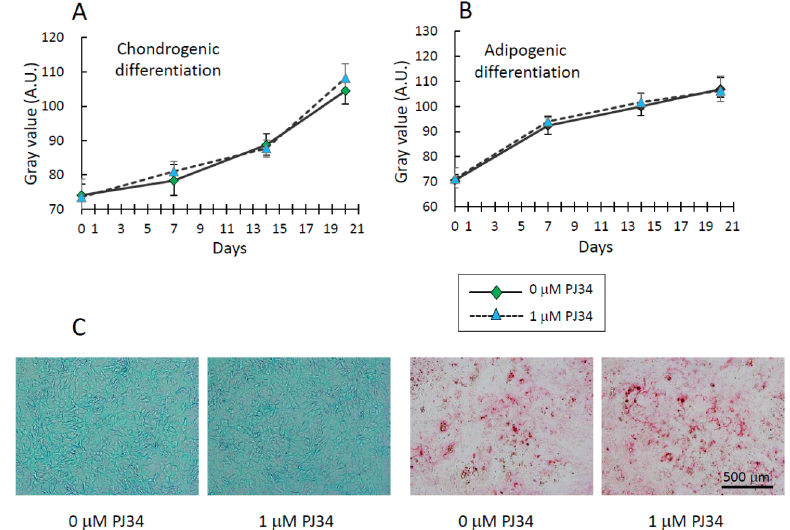
Figure 6. ( A ) Effects of PJ34 on chondrogenic differentiation of BMMSCs were analyzed by Alcian Blue staining.; ( B ) Effects of PJ34 on adipogenic differentiation of BMMSCs were analyzed by Oil Red O staining; ( C ) Representative photos of Alcian Blue staining ( Left ) and Oil Red O staining ( Right ) of BMMSCs 21 days differentiation into chondrogenic and adipogenic, respectively. Values are expressed as mean ± SEM. A.U. = Arbitrary Unit. Scale bar = 500